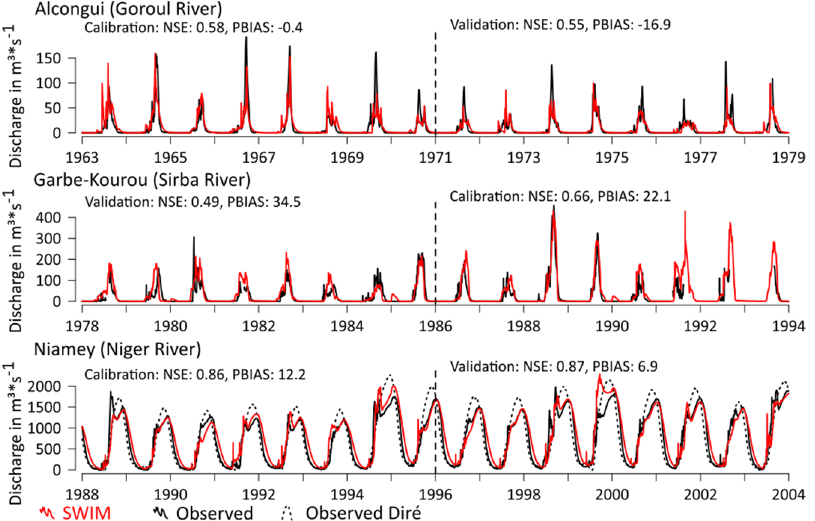
Figure 8. Validation and calibration of the SWIM model for the watersheds of Alcongui, Garbe-Kourou and Niamey for eight-year periods using PGFv2 reanalysis climate forcing. For Niamey, the measured discharge at the Diré gauge is additionally plotted, which is fed into the